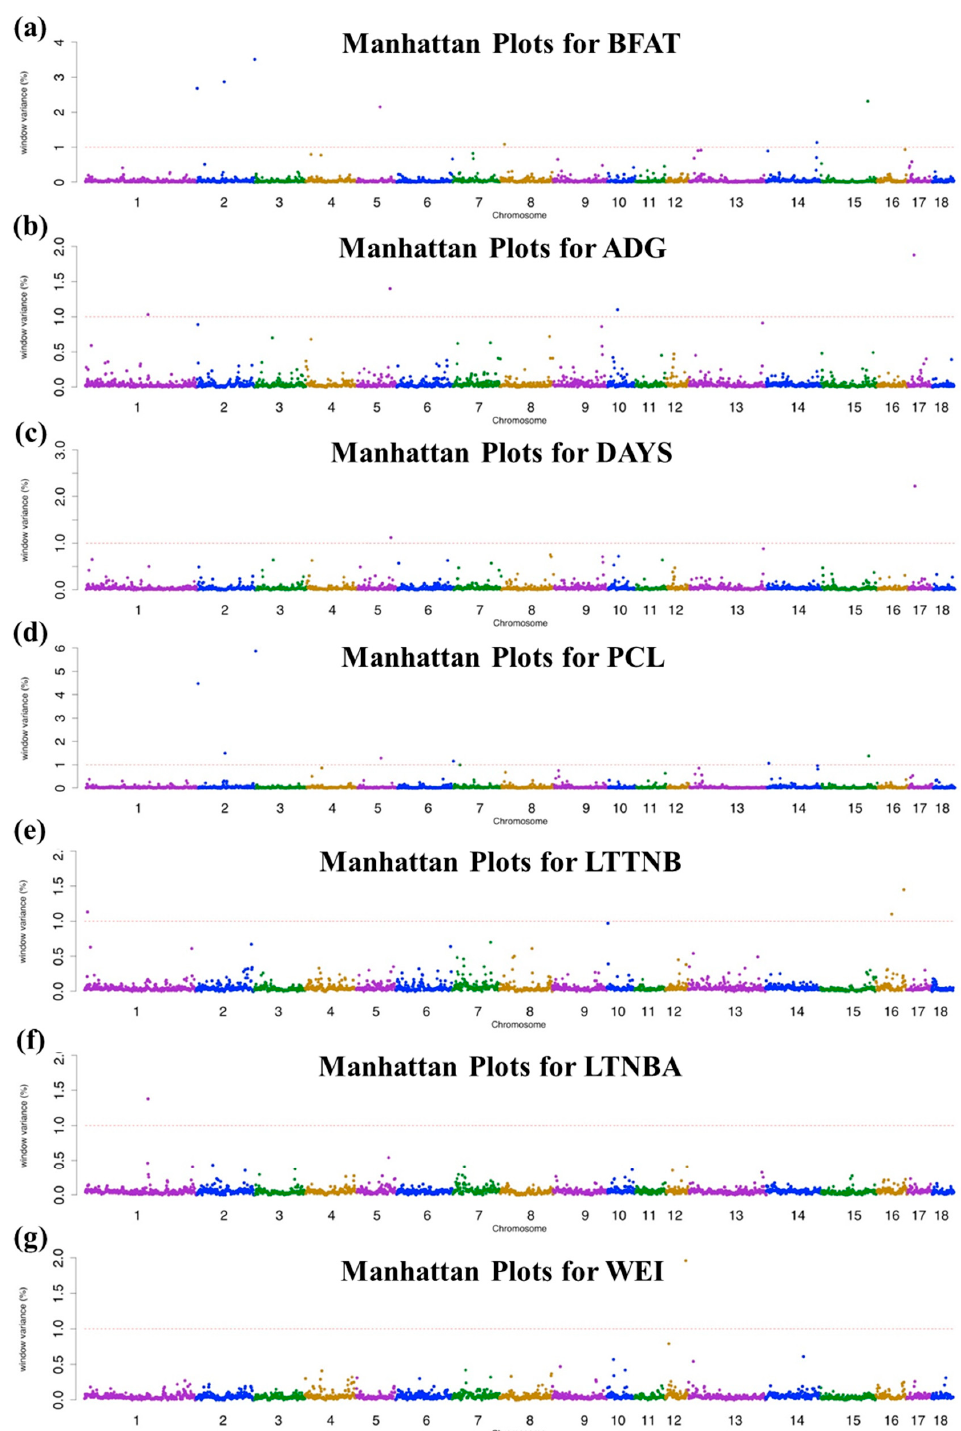
Figure 1. Manhattan plot of genome-wide association study result of 18 porcine autosomes. The y-axis indicates window variance (%) and x-axis represents the pig autosomal chromosome physical map. The red dot horizontal lines represent the threshold of the percent variance of 1-Mb genomic region used was above 1.0% to identify associations with traits: ( a ) backfat thickness (BFAT), ( b ) average daily gain (ADG), ( c ) days to 90-kg body weight (DAYS), ( d ) lean percent (PCL), ( e ) lifetime total number of born (LTTNB), ( f ) lifetime number of born alive (LTNBA), and ( g ) weaning to estrous interval